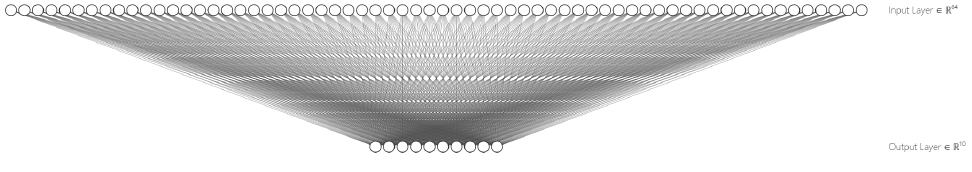
Figure 4. Graphical representation of the MLP neural network of scenario 1.